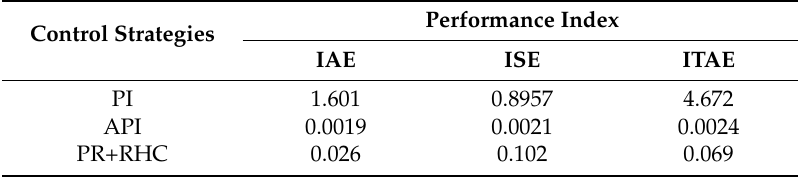
Table 7. Performance evaluation of the designed control strategies for I q .